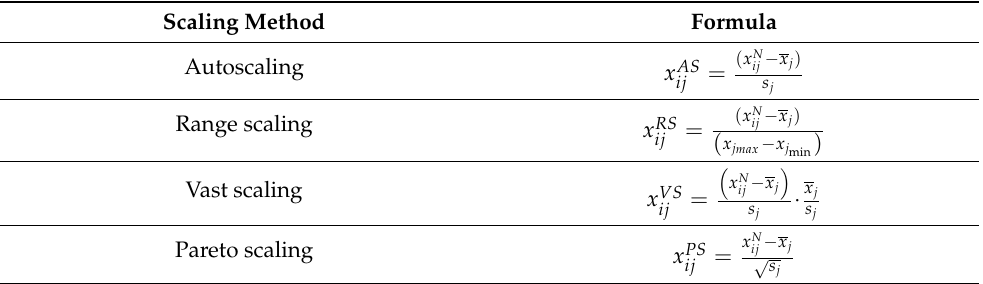
Table 2. Overview of the scaling methods used in metabolomics [30,31]. x ij is an element located in the i th row and the j th column. x j and s j are, respectively, the mean and the standard deviation of the values of the j th